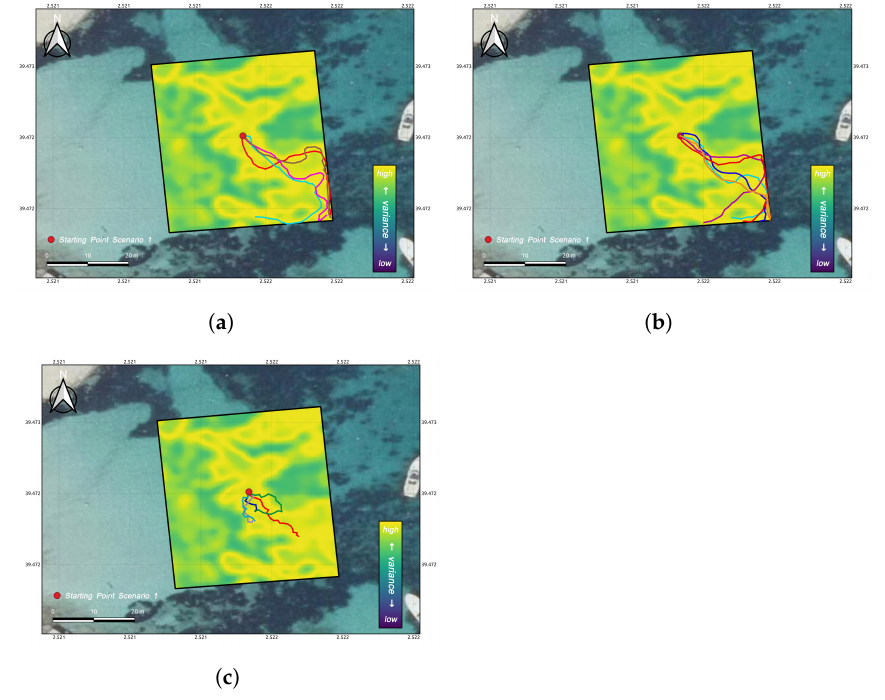
Figure 7. Five best paths Area 3-Scenario 1. ( a ) Genetic; ( b ) Random; ( c ) S-B.